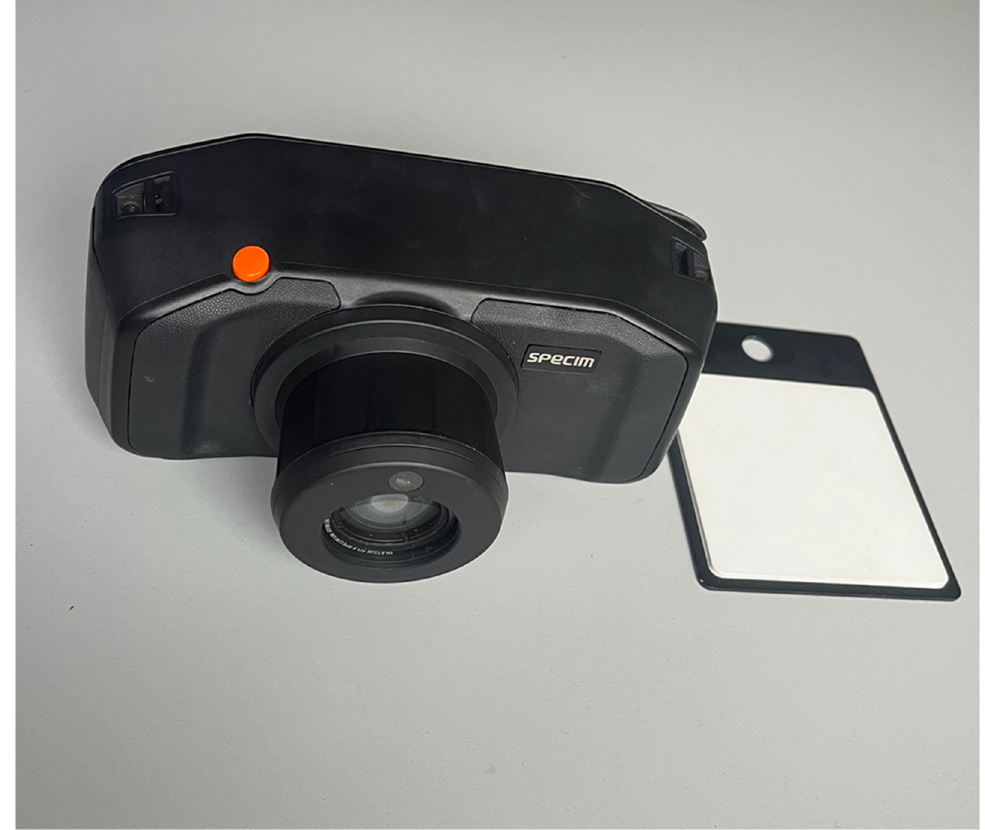
Figure 3. The hyperspectral camera with a gray panel.